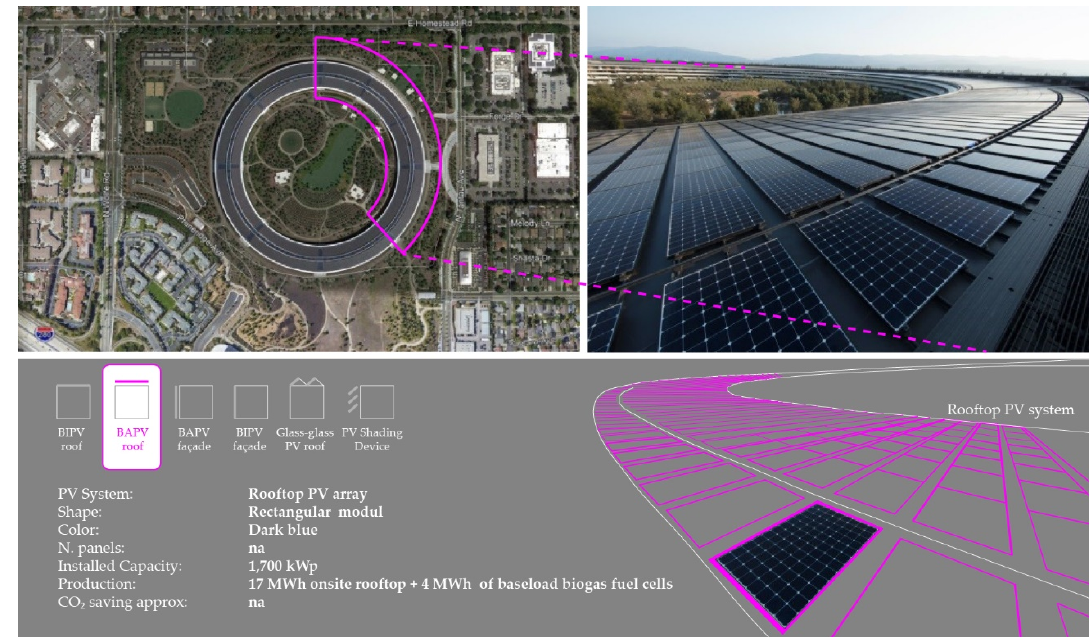
Figure 6. Apple Headquarters, aerial view of Apple Park (source: Google Earth, Google 2020) ( on the top left) and BAPV detail (with permission from Apple) ( on the top right ); Integration and characteristics of PV systems ( on the bottom ).